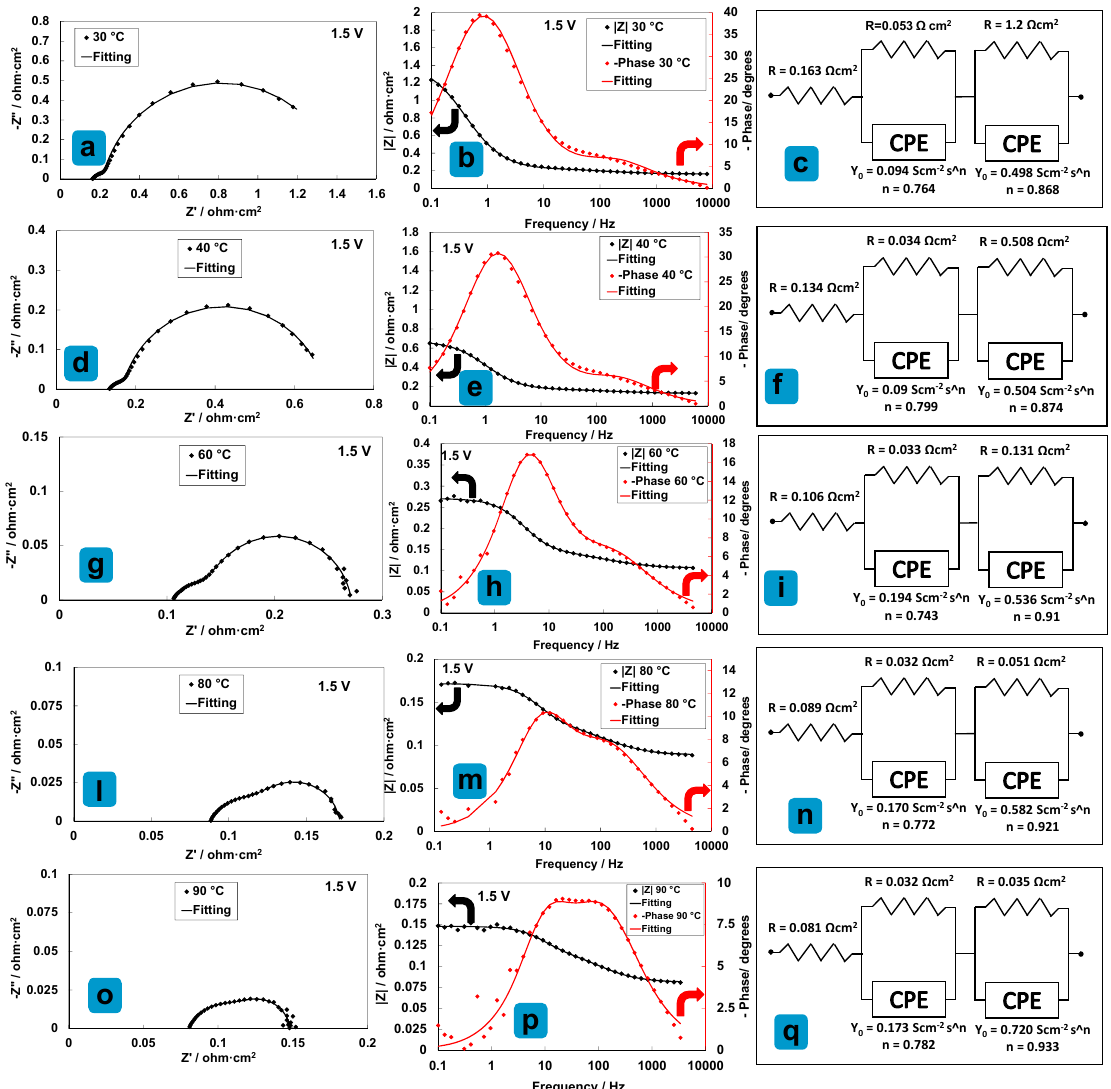
Figure 5. EIS analysis at 1.5 V and increasing temperatures for the medium catalyst loading (1.6 mg cm − 2MEA )-based MEA. Nyquist plots are reported in ( a , d , g , l , o ); Bode plots are reported in ( b , e , h , m , p ); equivalent circuits are reported in ( c , f , i , n , q ).